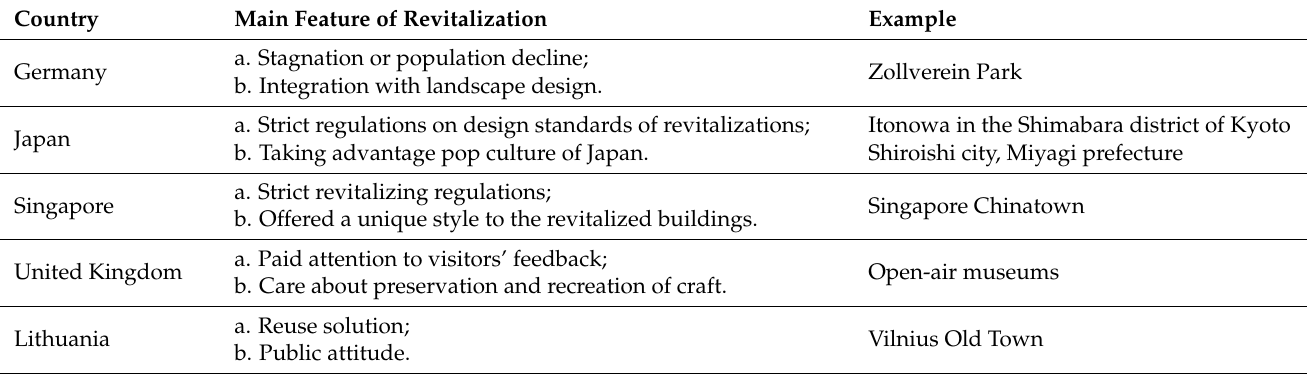
Table 1. The comparison of overseas revitalizations from different